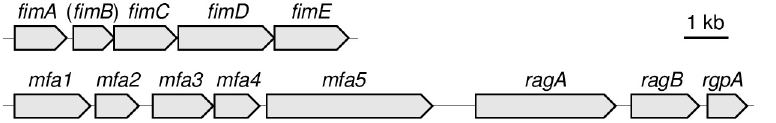
Fig 1. Gene map of the fim , mfa , and rag gene clusters of a type strain (ATCC 33277) of P . gingivalis . There are distances between the fim gene cluster ( fimA to fimE ), as well as mfa ( mfa1 to mfa5 ) and rag ( ragA and ragB ) gene clusters. The fimB gene is placed in parentheses because there is a nonsense mutation in ATCC 33277. Arrows depict gene directions from 5 0 to 3 0